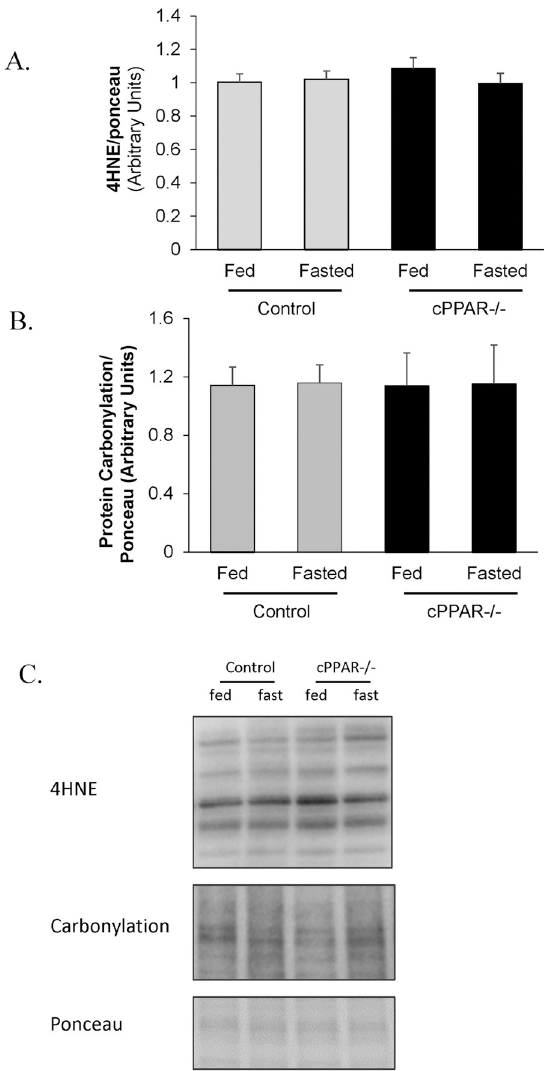
Fig 5. Control or fasted mice with reduced myocardial PPAR α do not have elevated levels of protein oxidation. Mice were fasted were 16 hrs and then A. 4-HNE and B. protein carbonylation levels were measured in heart. C. Representative western blot images. Values are mean ± SEM. n =